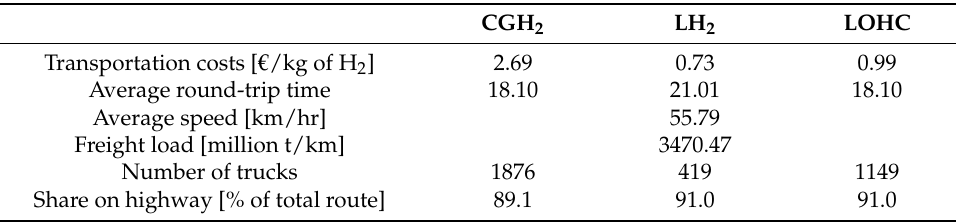
Table 7. Comparison between the weighted results for transportation